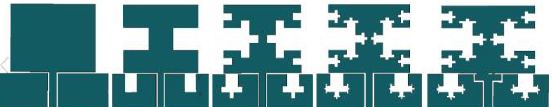
Figure 1: Structure transformation of antenna (a) 0 th